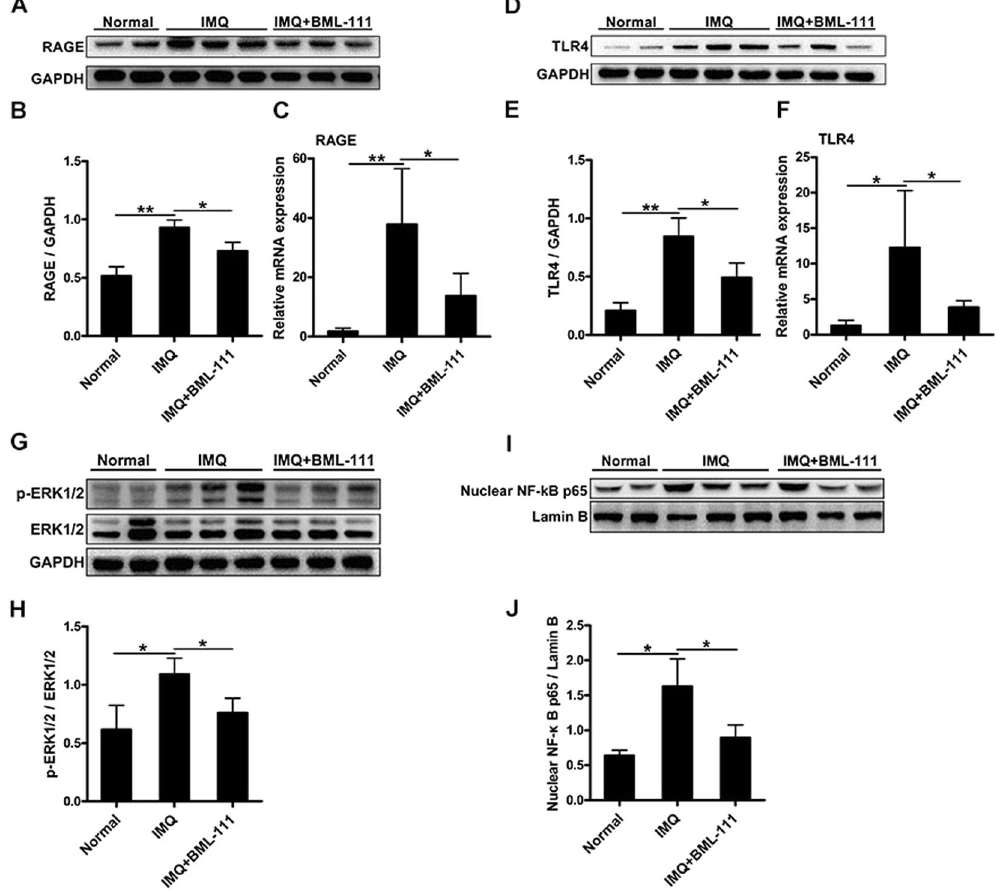
Figure 3. BML-111 suppresses the expression of proteins related to RAGE and TLR4 signaling in IMQ-induced psoriasiform dermatitis in mice. Protein levels of RAGE ( A , B ), TLR4 ( D , E ), ERK1/2 and p-ERK1/2 ( G , H ), and nuclear NF- κ B p65 ( I , J ) were analyzed by western blotting. Full-length blots are presented in Suppl. Figures S2–S5. mRNA levels of RAGE ( C ) and TLR4 ( F ) were analyzed in the three groups of mice. The results are shown as the mean ± SD. ** p < 0.01 and * p < 0 . 05 , compared to mice treated with IMQ. All experiments were conducted thrice, and the representative results are